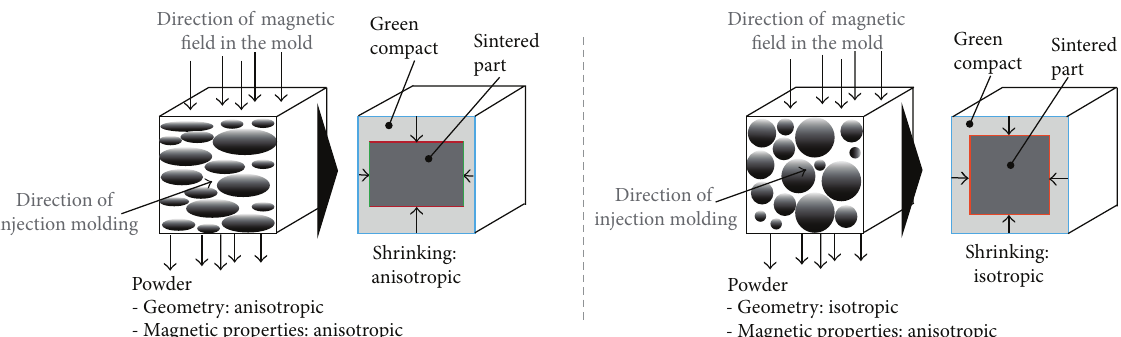
Figure 7: Isotropic and anisotropic shrinkage as a function of particle